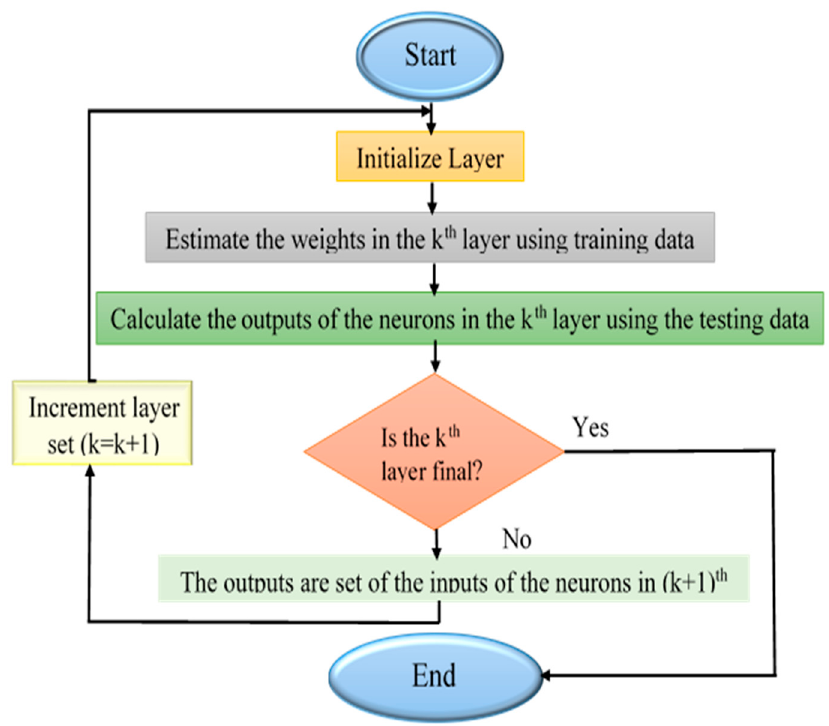
Figure 5. GMDH network flow chart.